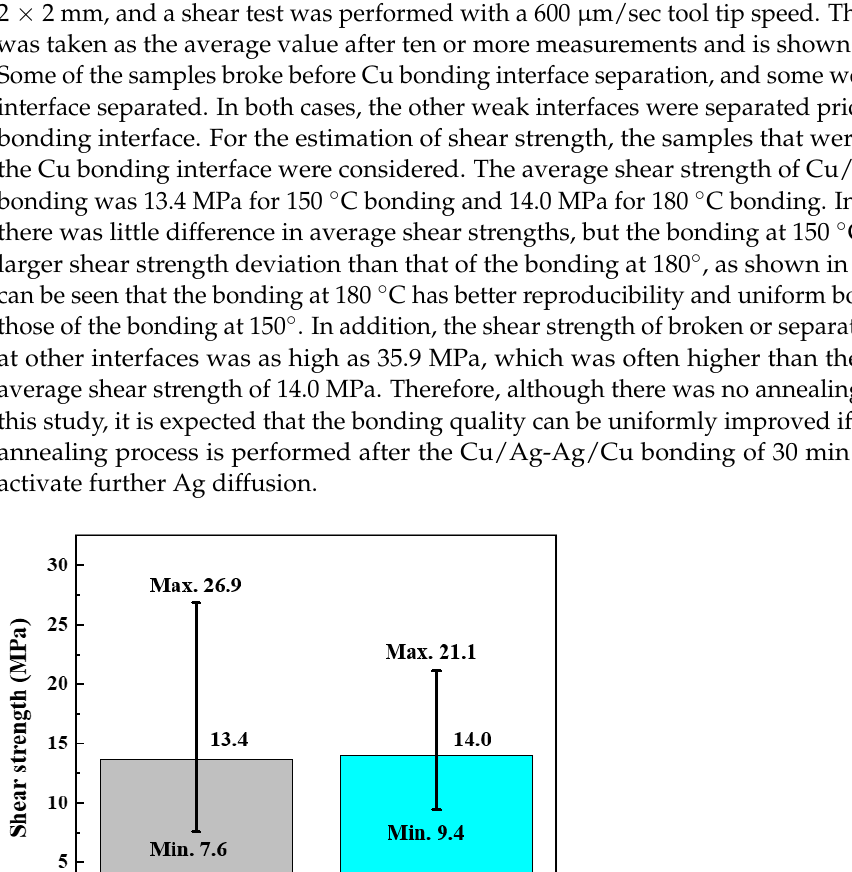
Figure 5. EDS measurements of Cu/Ag ‐ Ag/Cu bonding interface (sample bonded at 150 °C).